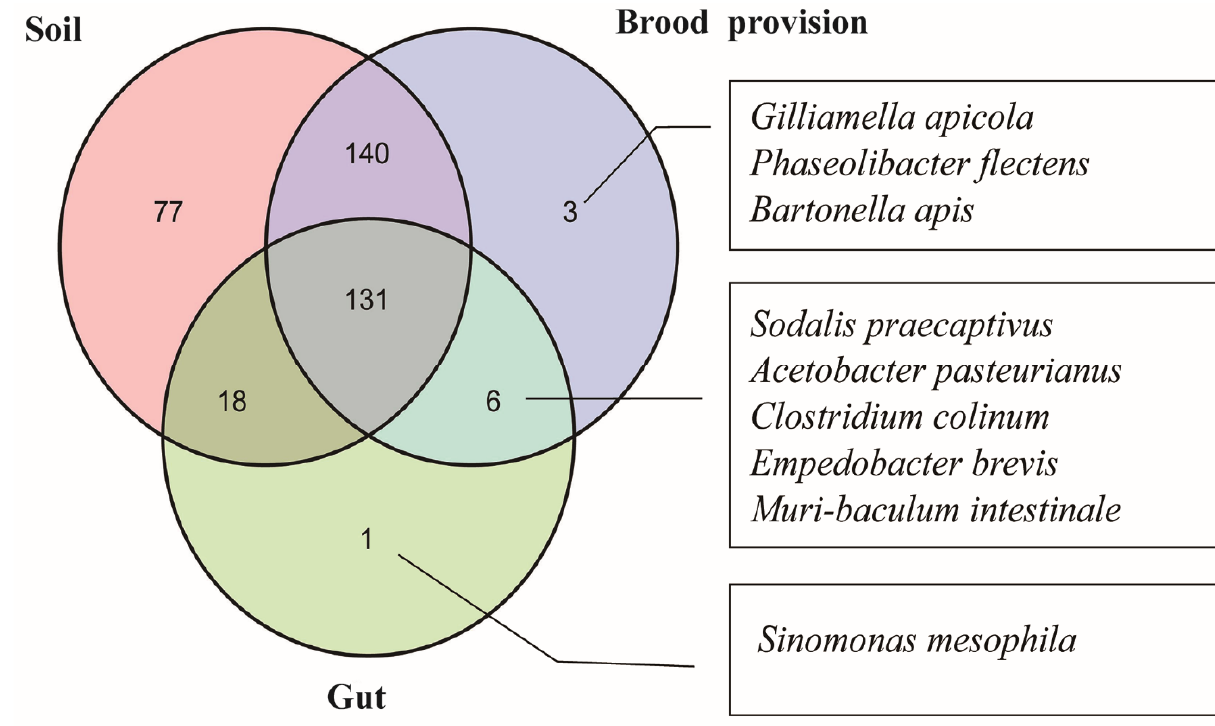
Figure 1. Venn diagram of OTUs assignments illustrating the number of taxa shared in and between gut, brood provision and nest soil.